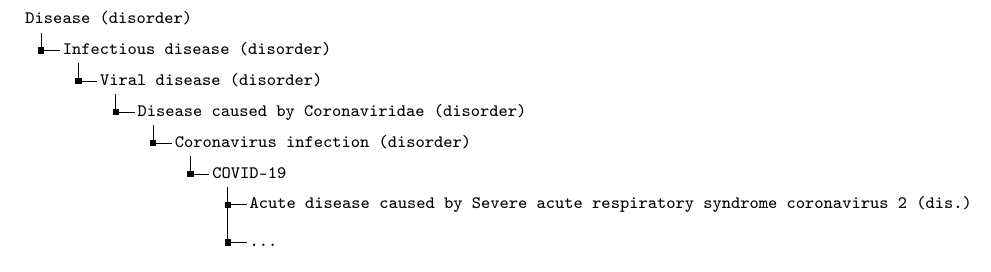
Figure 4. Example hierarchy in SNOMED-CT. Table 4. Comparison of medical categorization